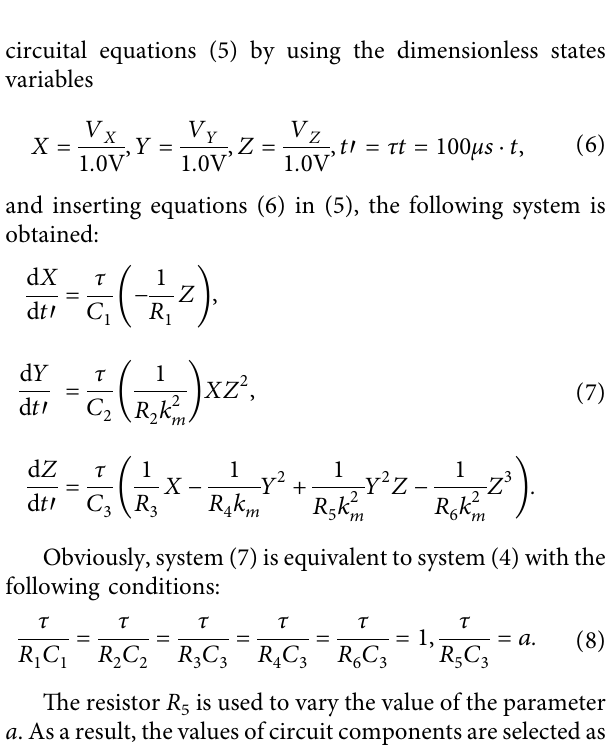
t t t , y , and z while the (b) phase portraits in the different planes for a ( ) ( ) ( )